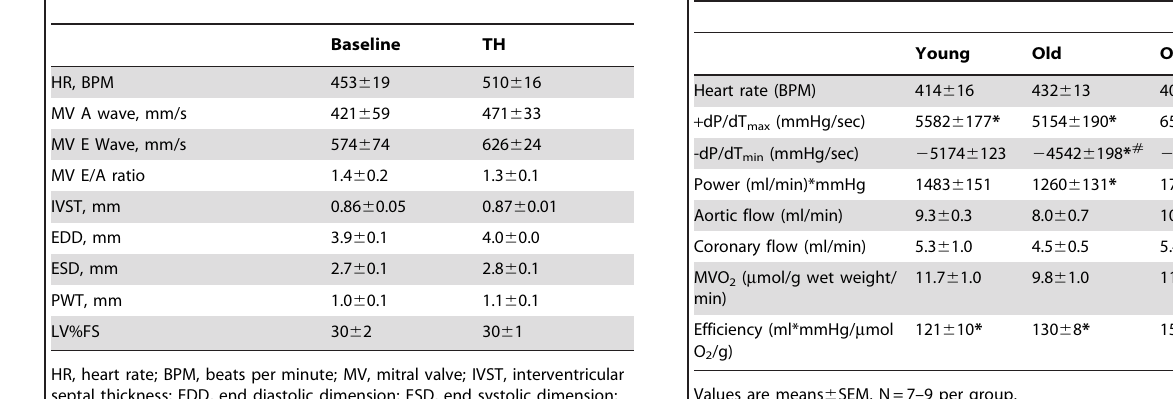
Table 1. Echocardiographic analysis of the left ventricle at baseline and after thyroid hormone treatment.